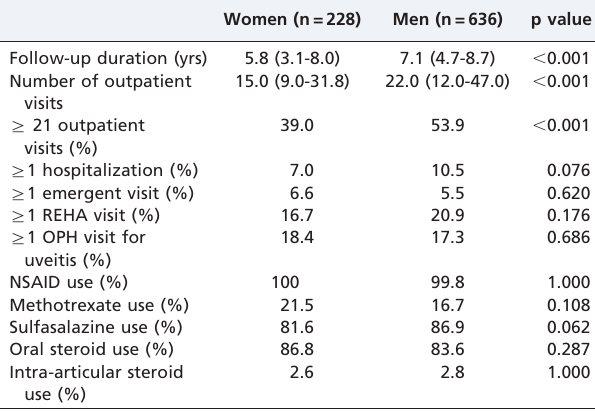
Table 2 - Comparison of cumulative healthcare utilization associated with ankylosing spondylitis between men and women (1996-2007)*.